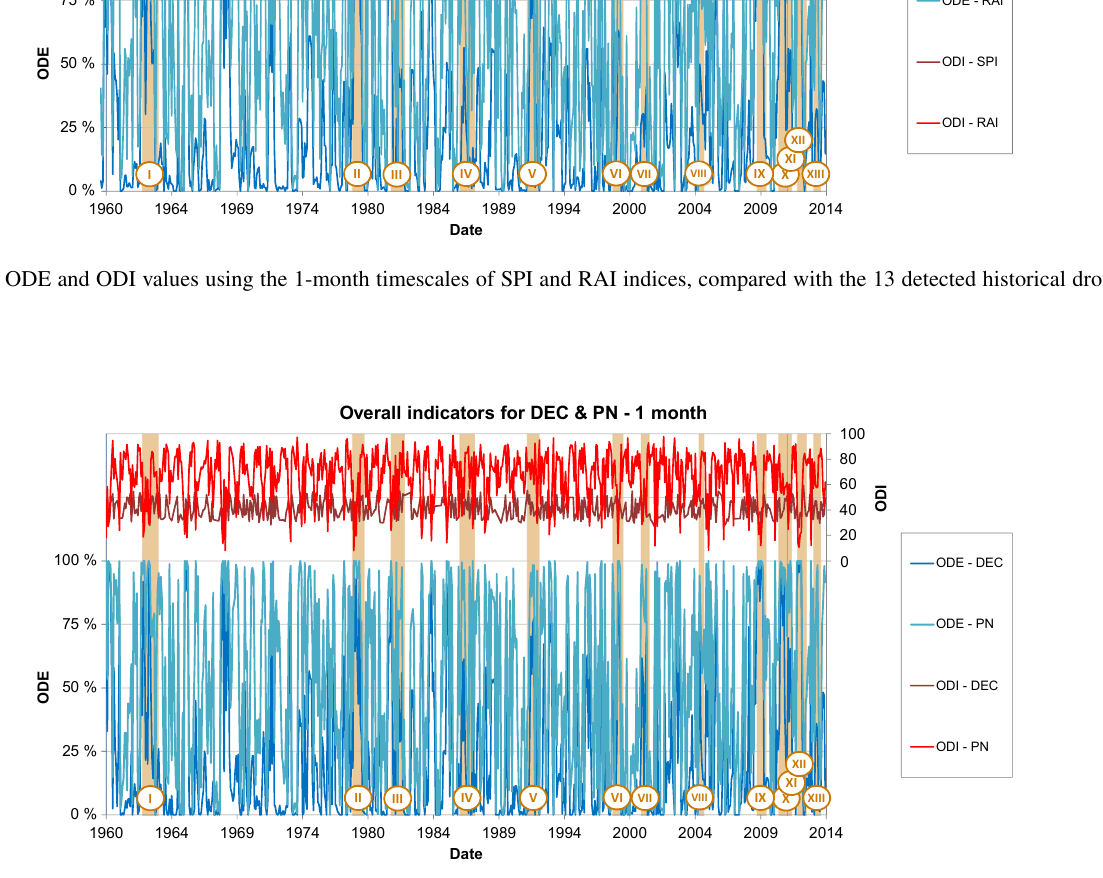
Figure A2. ODE and ODI values using the 1-month timescales of DEC and PN indices, compared with the 13 detected historical droughts (in